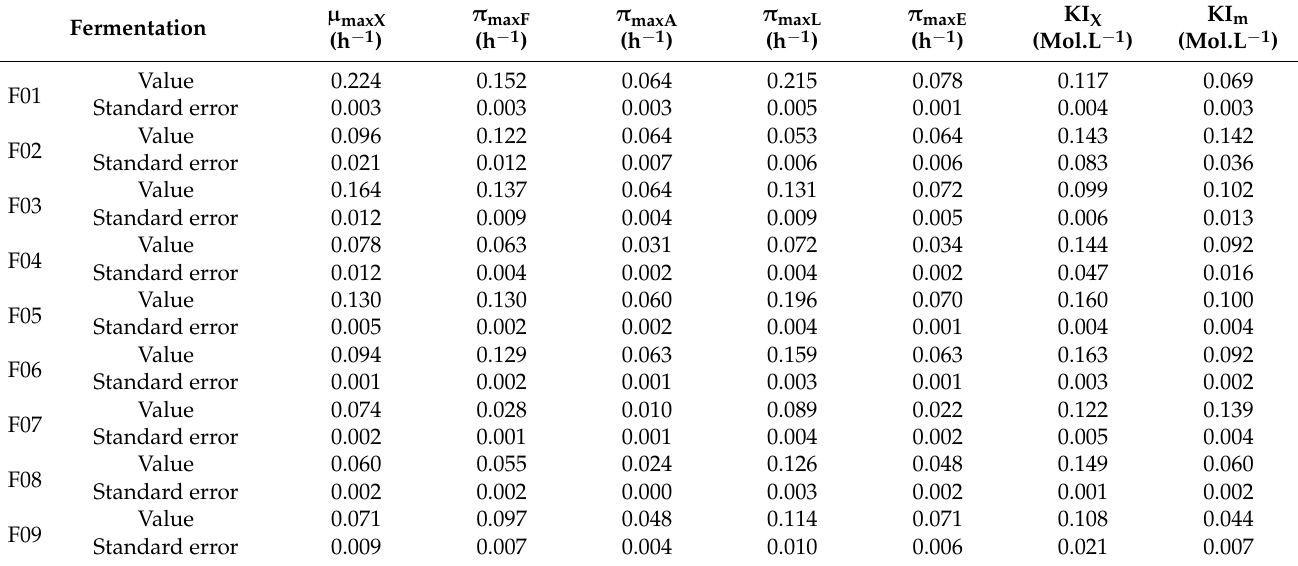
Table 2. Model parameters determined for each experiment by nonlinear